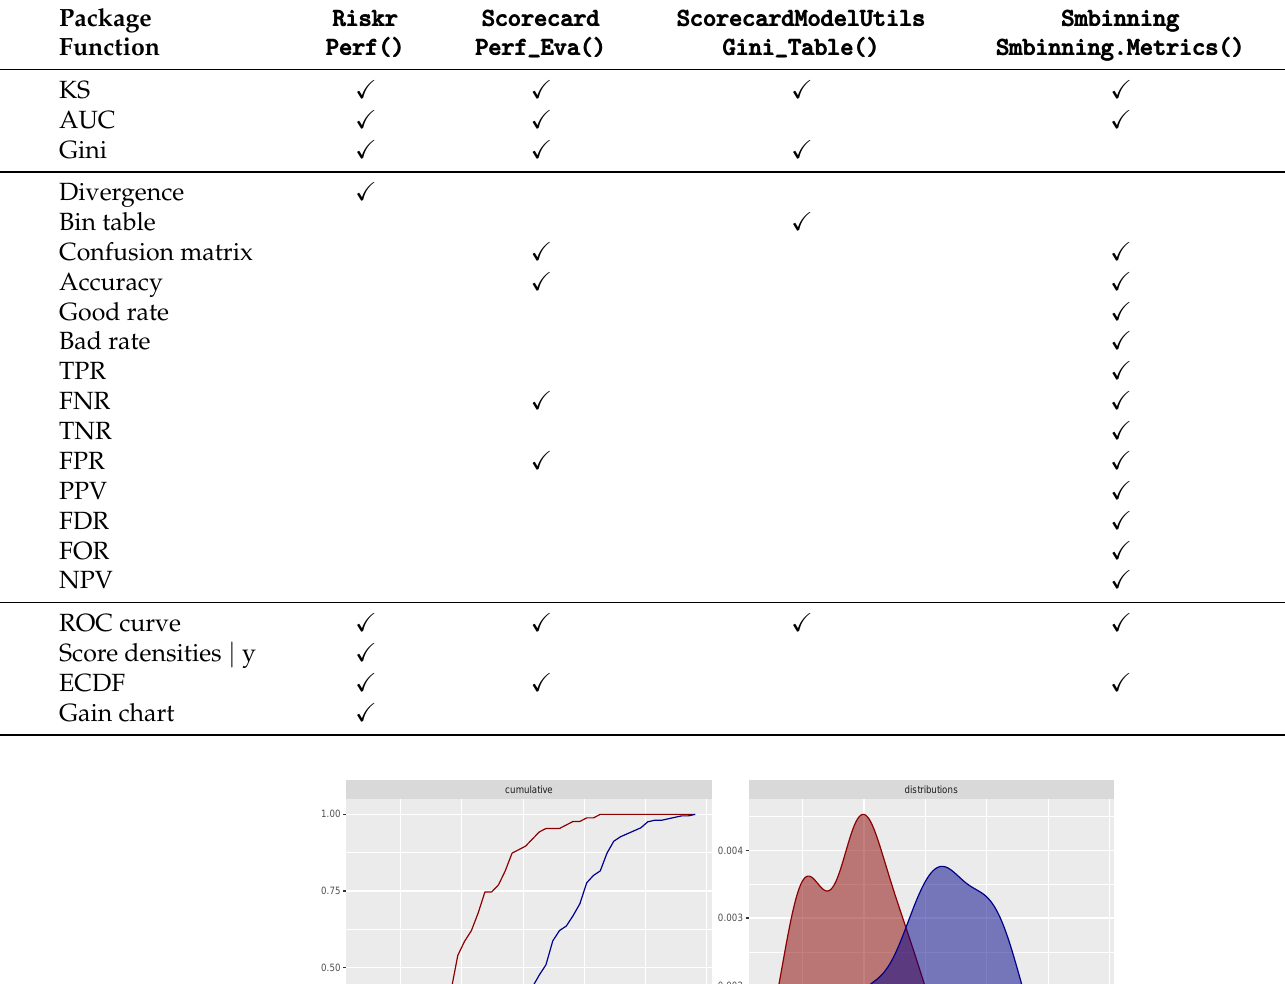
Table 5. Overview of scorecard performance summary functions.